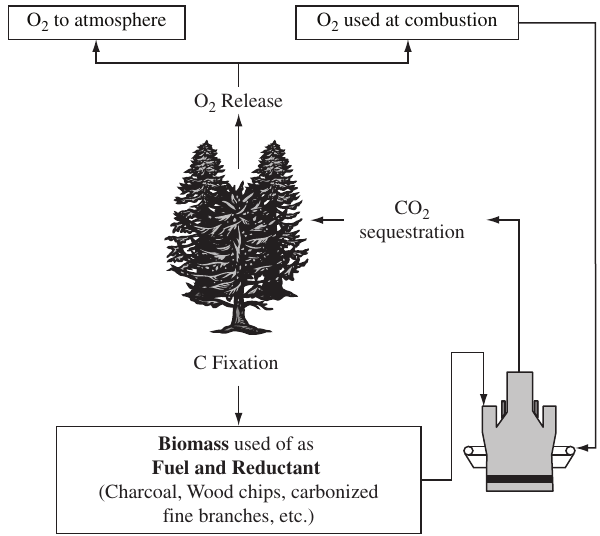
Figure 6. Cycle of CO